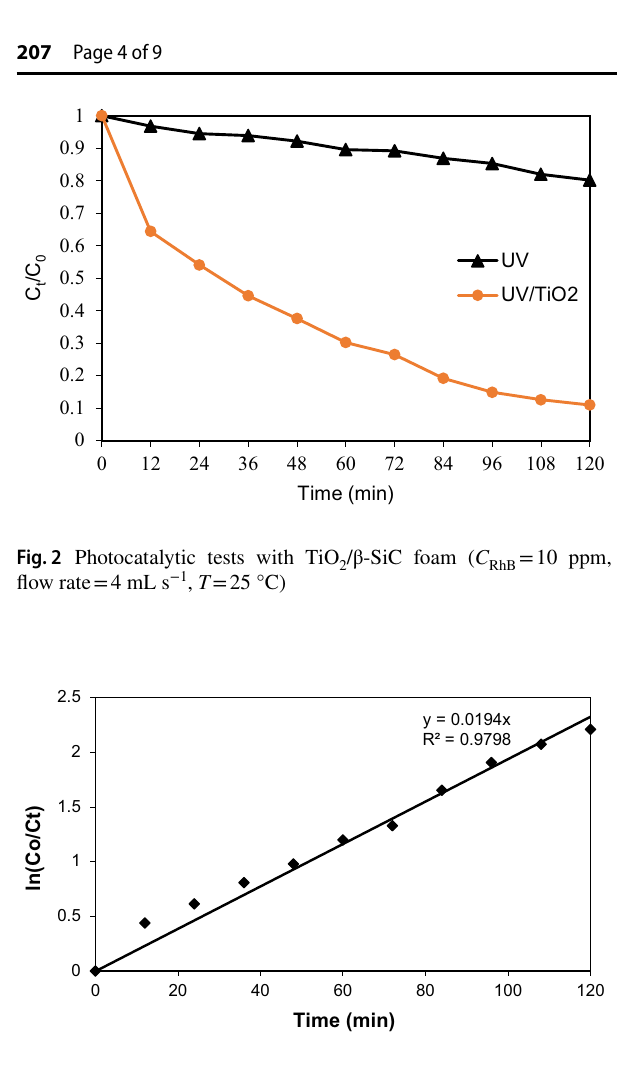
Fig. 3 Linearization from Langmuir–Hinshelwood model